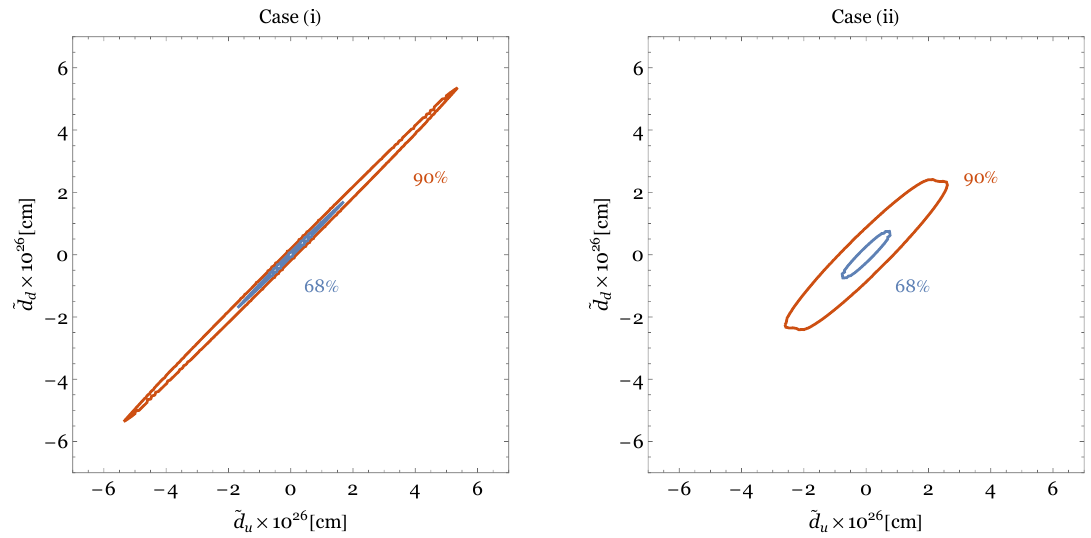
Figure 17 . The mercury EDM constraint on the quark CEDMs. The left and right panels corre- spond to the case (i) and (ii). The outer regions of the contours are excluded. The blue and orange contours denote the constraints at 68% and 90% C.L.